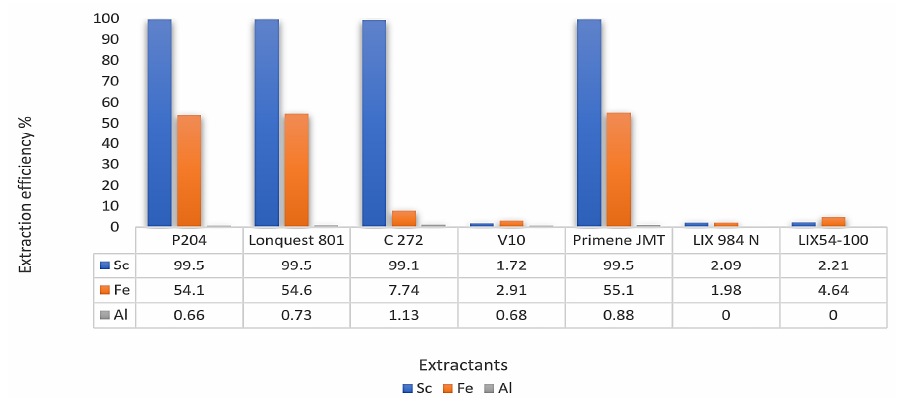
Figure 17. Extraction efficiency for different extractants at a pH of 1.5–2. (Shellsol D70 used as a diluent containing 3% of the extractants at an A/O ratio of 5), adapted from [149].